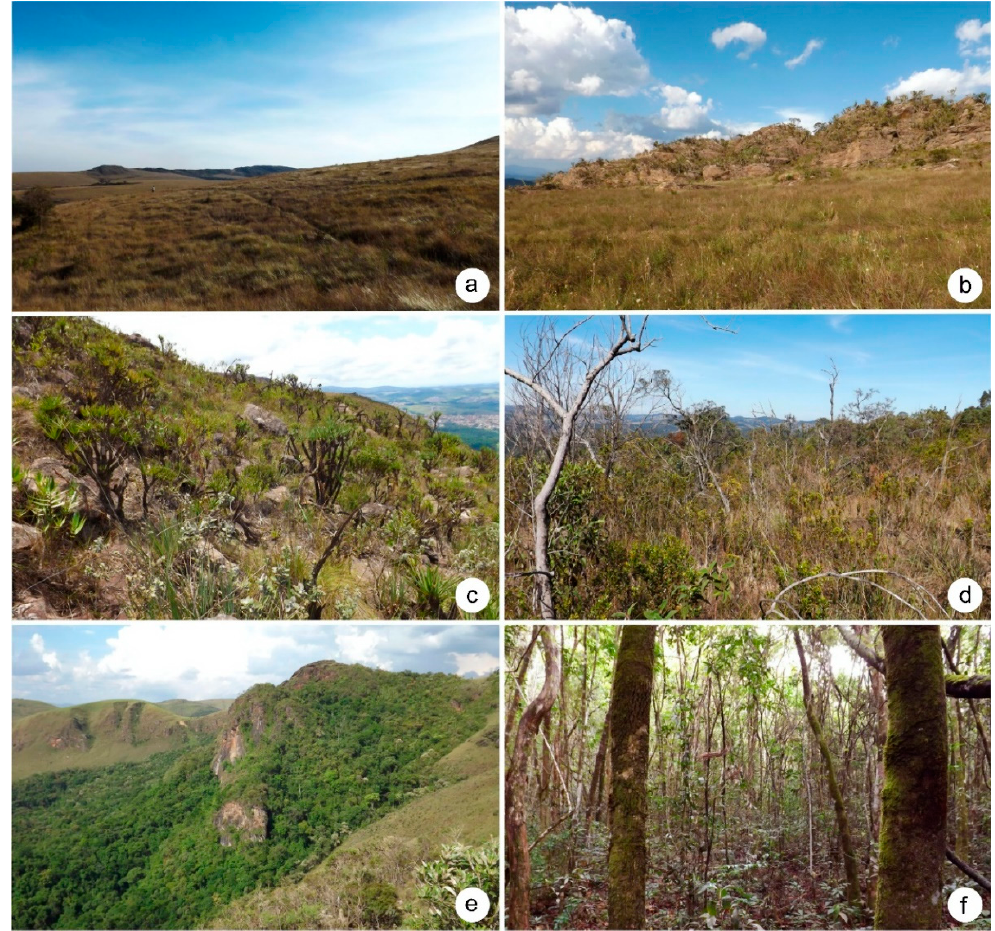
Figure 2. Main phytophysiognomies found in study area: ( a ) general view of the clean field; ( b ) clean field in the foreground and rocky outcrop in the rocky field in the background; ( c ) rocky field; ( d ) cerrados; ( e ) a view of the semideciduous forest (FES) on the northern slope of the mountain; and ( f ) inside the FES. Photos: T.L. Vieira [32].